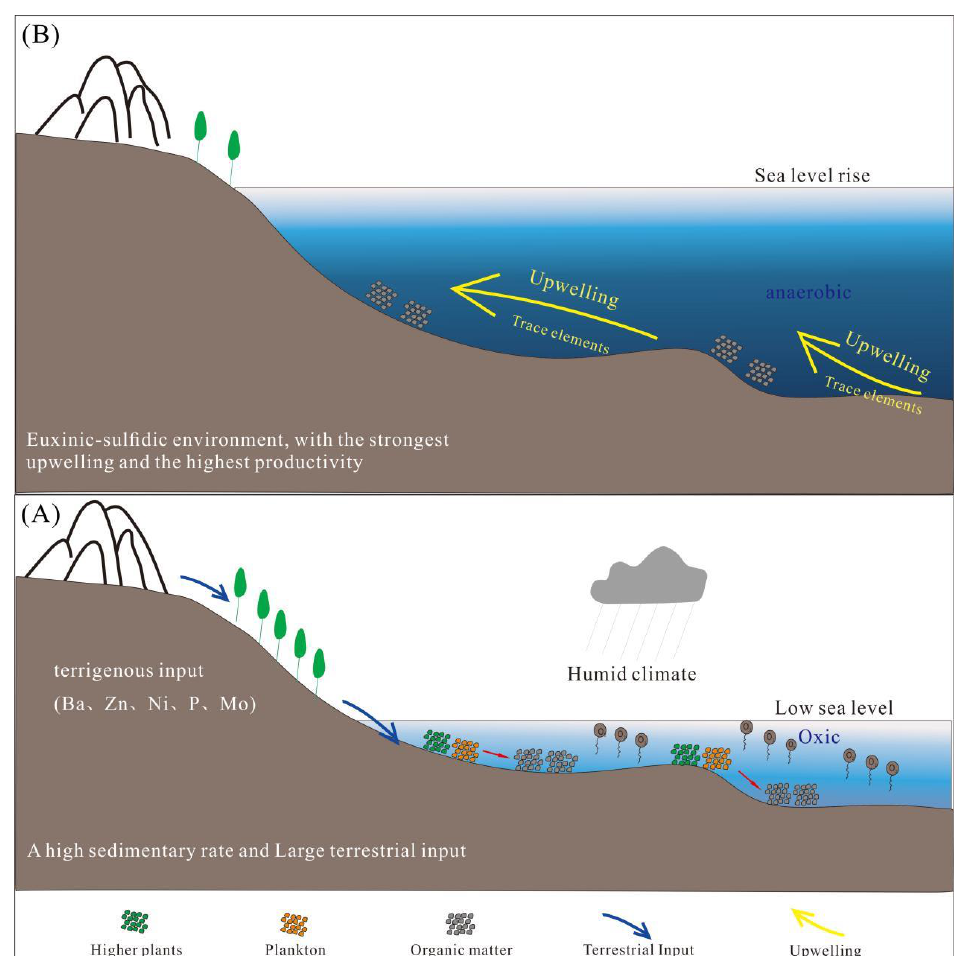
Figure 9. “Kaijiang - Liangping” Trough of the Wujiaping Formation shale organic matter enrich- Figure 9. “Kaijiang-Liangping” Trough of the Wujiaping Formation shale organic matter enrichment ment pattern. ( A ) Wujiaping ( lower ); ( B ) Wujiaping ( upper ). pattern. ( A ) Wujiaping ( lower ); ( B ) Wujiaping ( upper